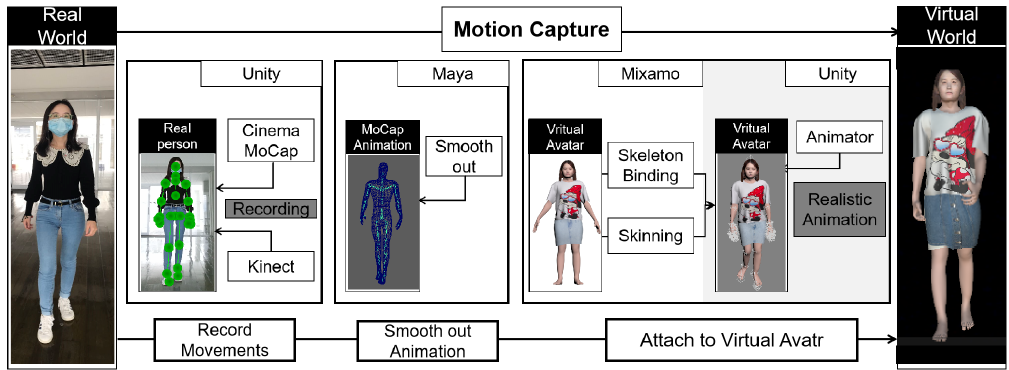
Figure 7. Framework of motion